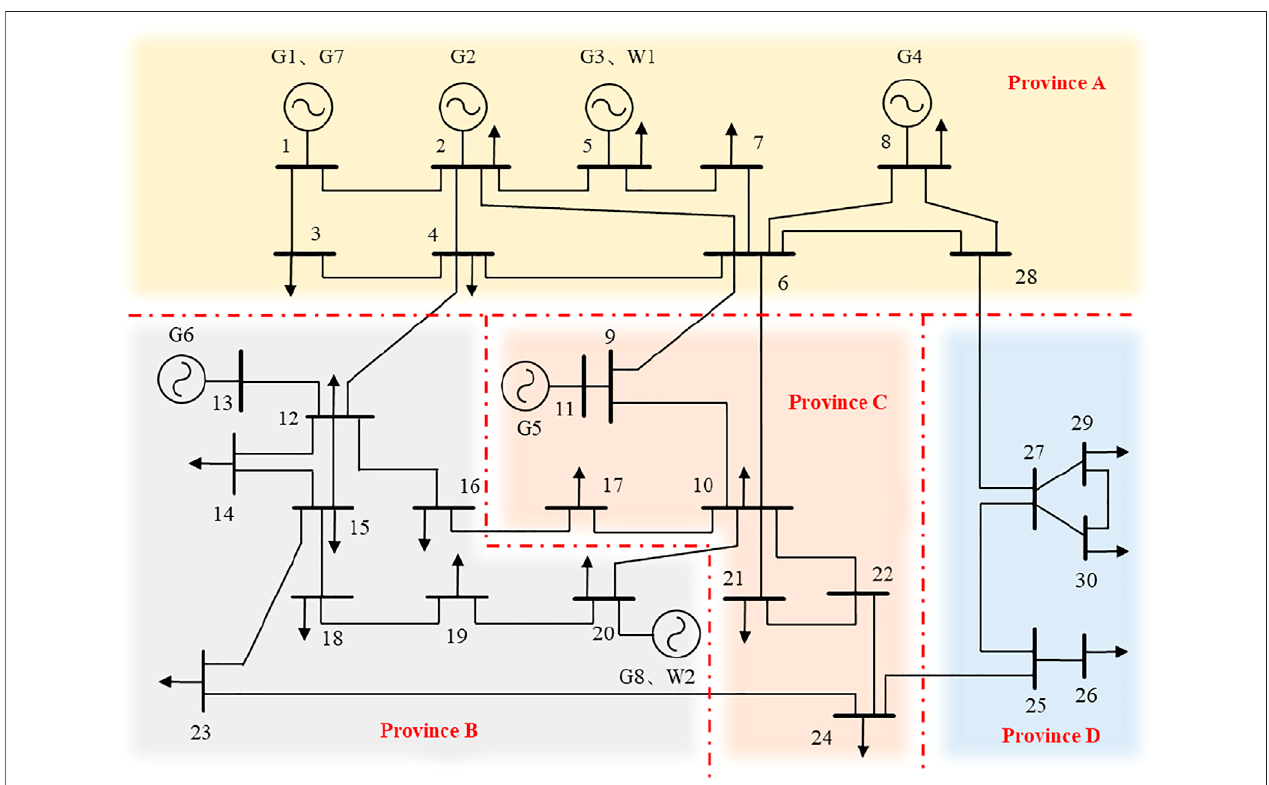
FIGURE 5 | A revised structure diagram of the IEEE 30-bus system under study.